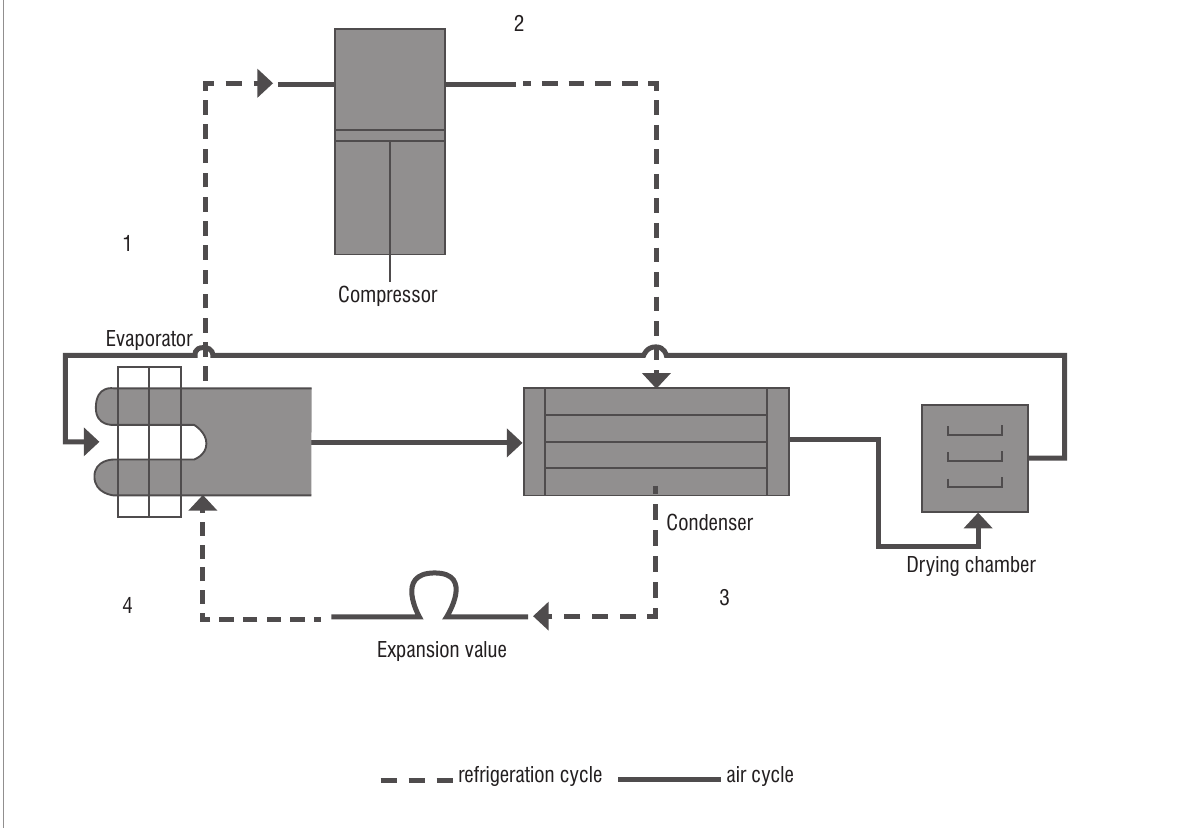
Figure 1: Schematic diagram of a heat pump